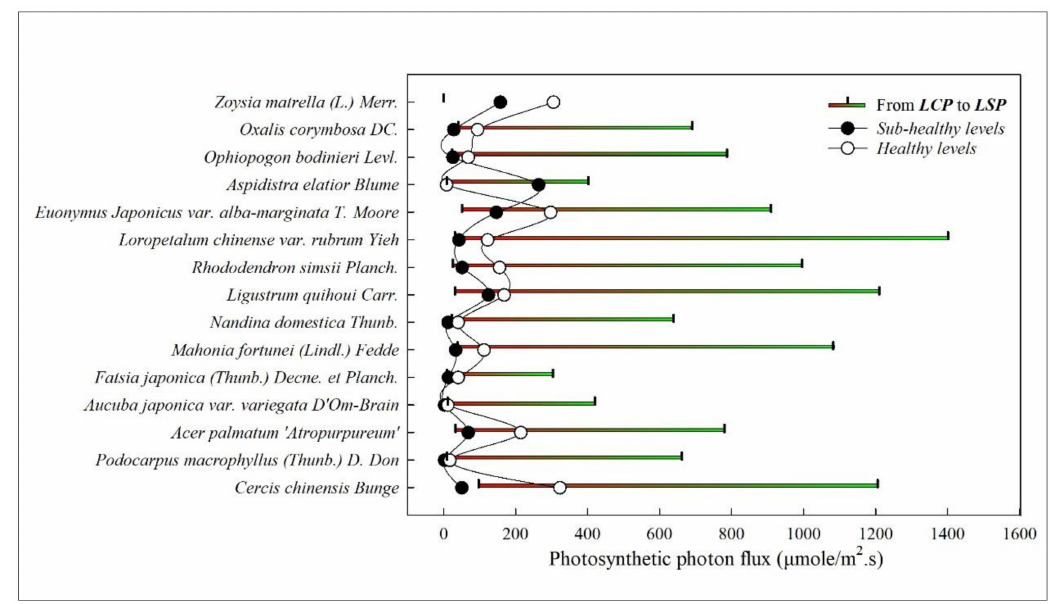
Figure 6. Numerical comparison between LCP-LSP and the sub-healthy and healthy levels, as measured by LI-6400XT and forecast by our digital framework,